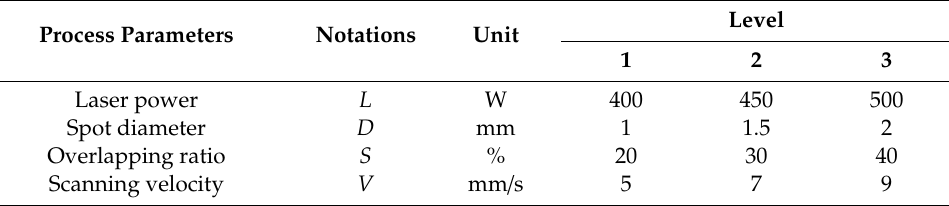
Table 1. Experimental factors and levels.